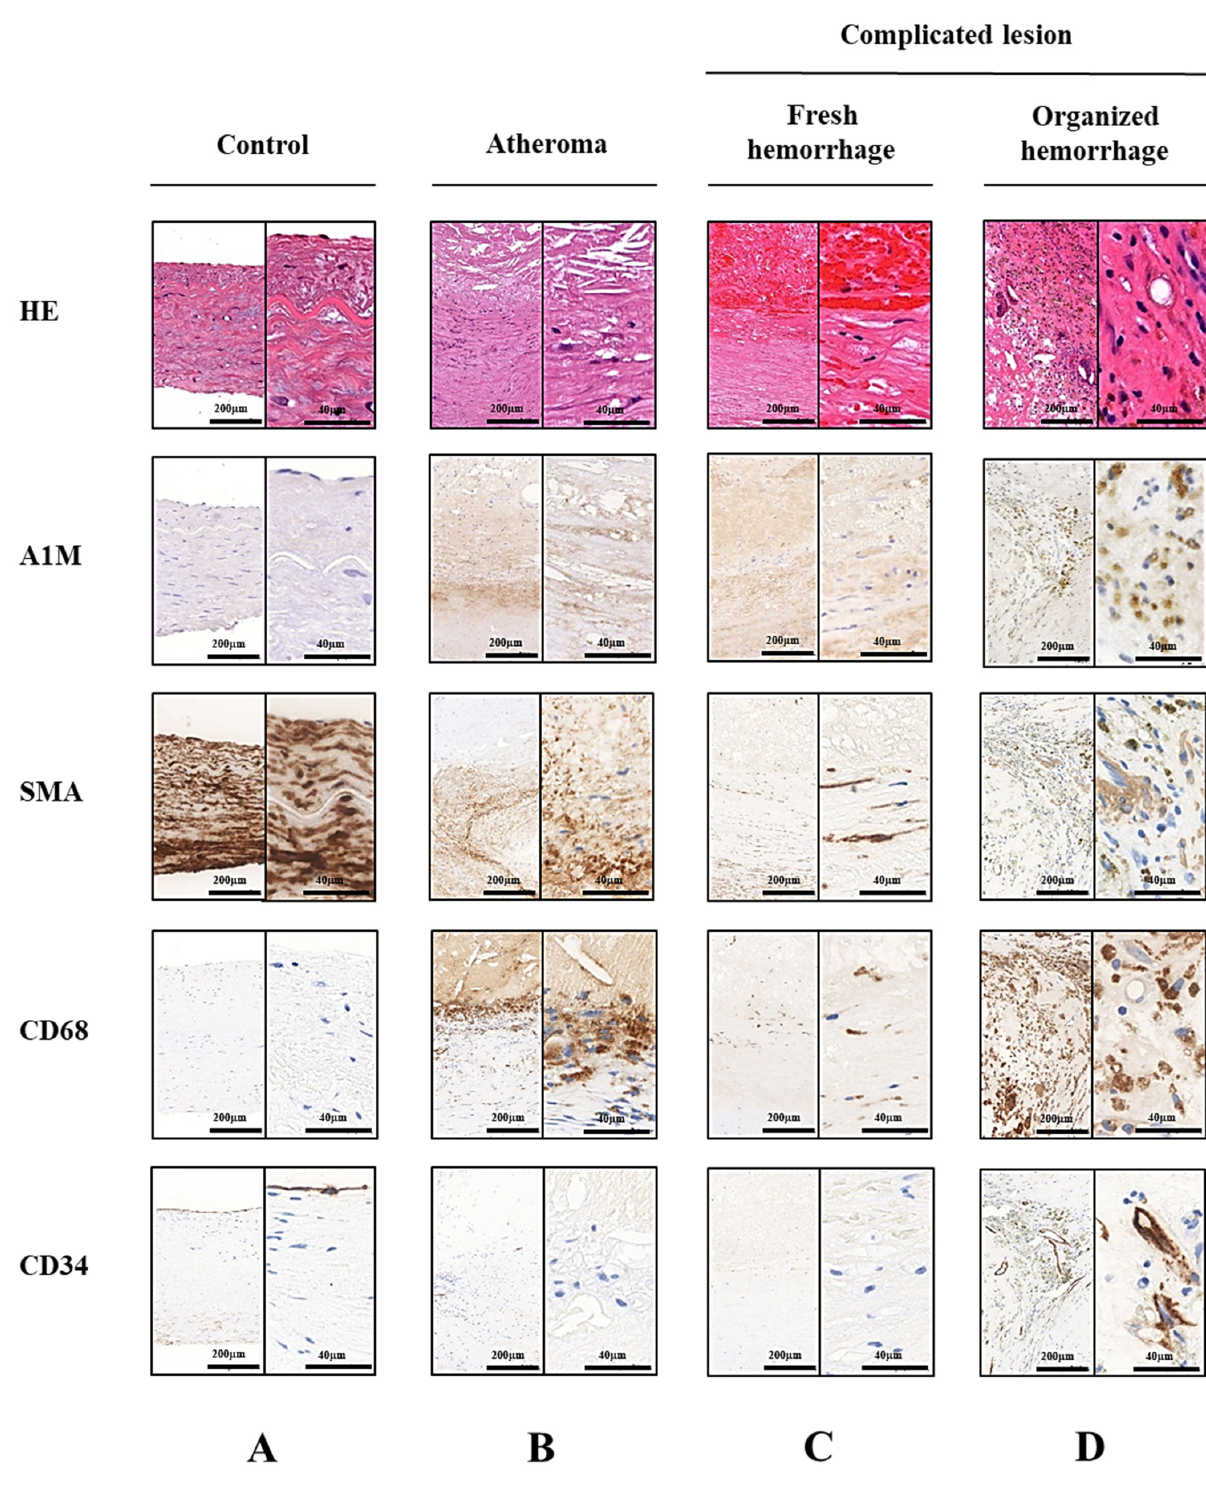
Figure 1. Localization of α 1 -microglobulin (A1M) in healthy carotid wall, atheromatous plaque and complicated lesion with fresh or organized hemorrhage. Serial sections of healthy carotid wall (Panel ( A )), atheromatous plaque (Panel ( B )), complicated lesion with fresh (Panel ( C )), or organized hemorrhage (Panel ( D )) are shown. Smooth muscle cells were identified by smooth muscle α -actin (SMA), macrophages by CD68 and endothelial cells by CD34 stainings. Red blood cells were visualized by hematoxylin-eosin (HE) staining.